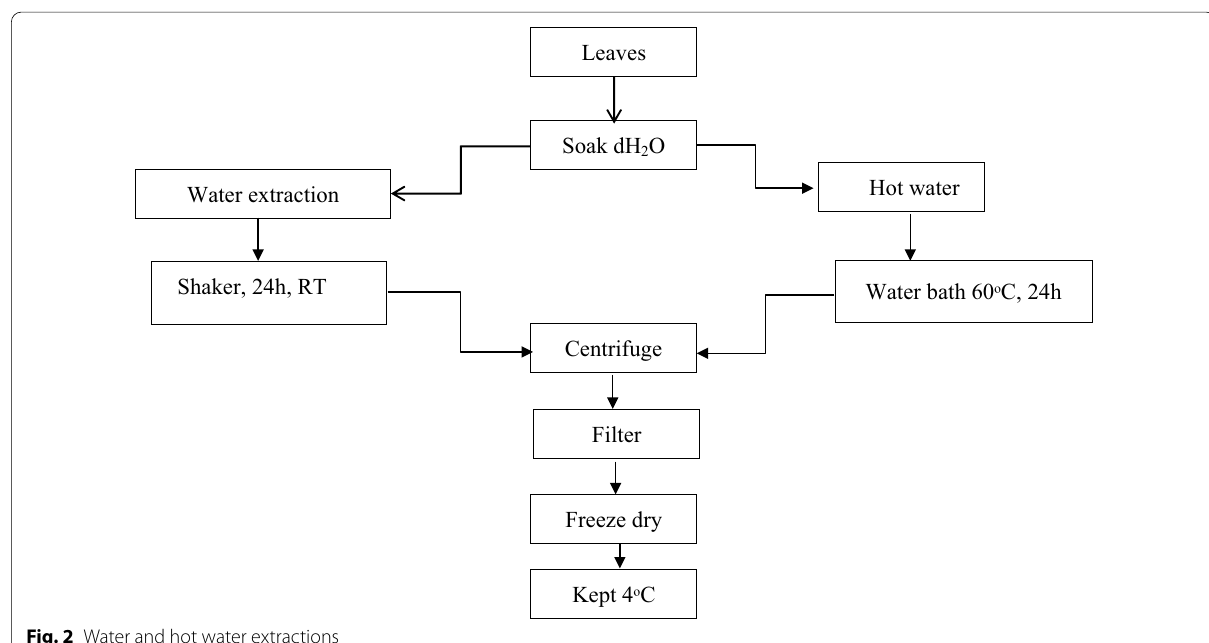
Fig. 2 Water and hot water